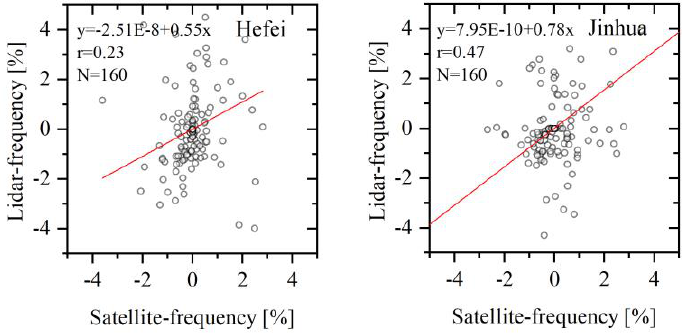
Figure 10. Seasonal occurrence frequency of cloud base height measured by CALIPSO and CloudSat or ground-based lidar.